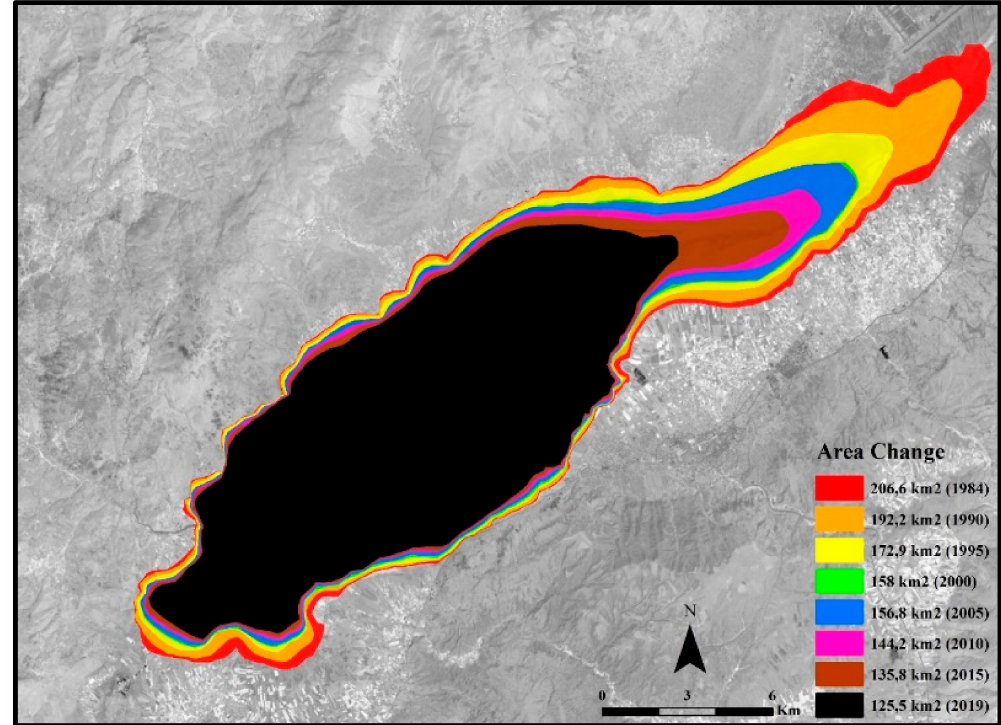
Figure 4. The coastline and areal changes of Burdur Lake’s water body according to years.